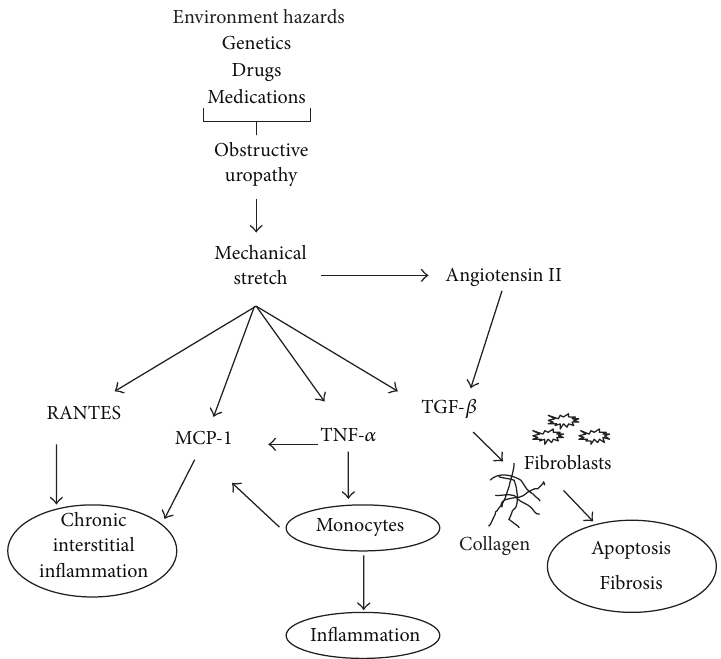
Figure 1: Potential mechanisms involved in obstructive